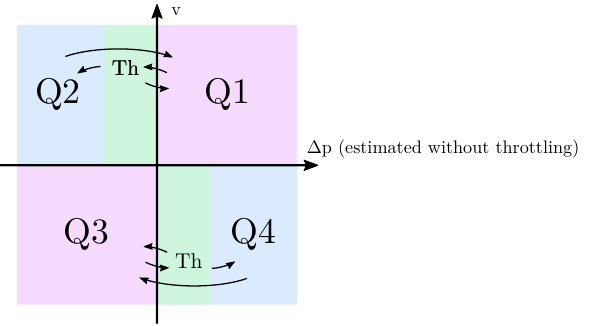
Figure 8. Working principle for active throttling. The green areas called Th corresponds to the throttling modes. The method has not been investigated in